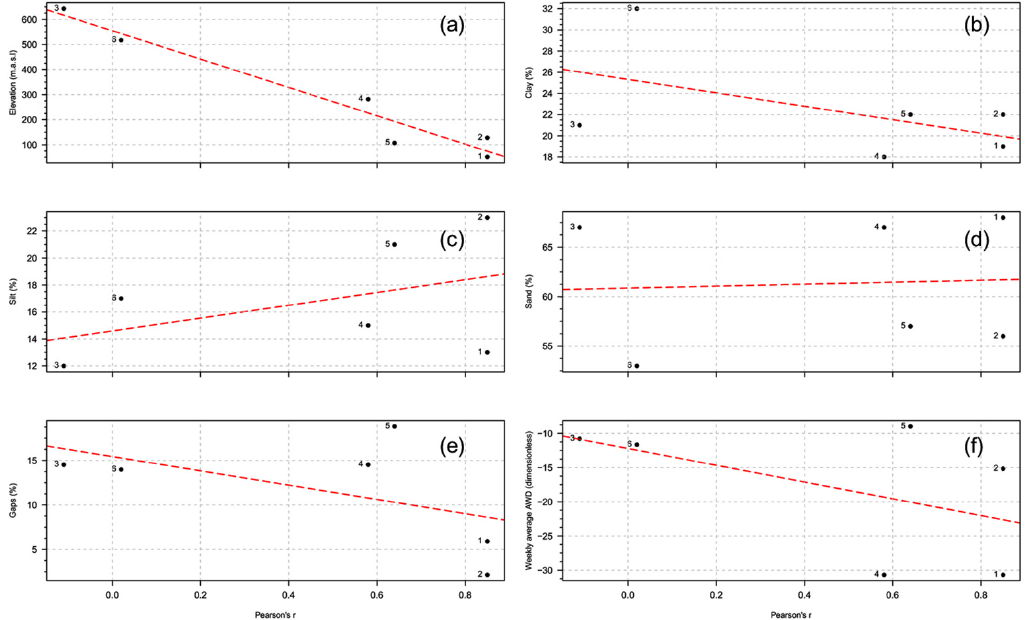
Figure 7. Comparison of the Pearson’s linear coefficient between the SWDIS and AWD ( r ) against: ( a ) elevation (m.a.s.l.); ( b ) clay (%); ( c ) silt (%); ( d ) sand (%); ( e ) gaps (%); and ( f ) weekly average AWD (dimensionless) taking into account all benchmark sites. Numbers are the IDs shown in Tables 1 and 2. Dashed red line depicts the linear regression best fit. Clay, silt, sand, and elevation were taken from Table 1, and gaps and r from Table 2.